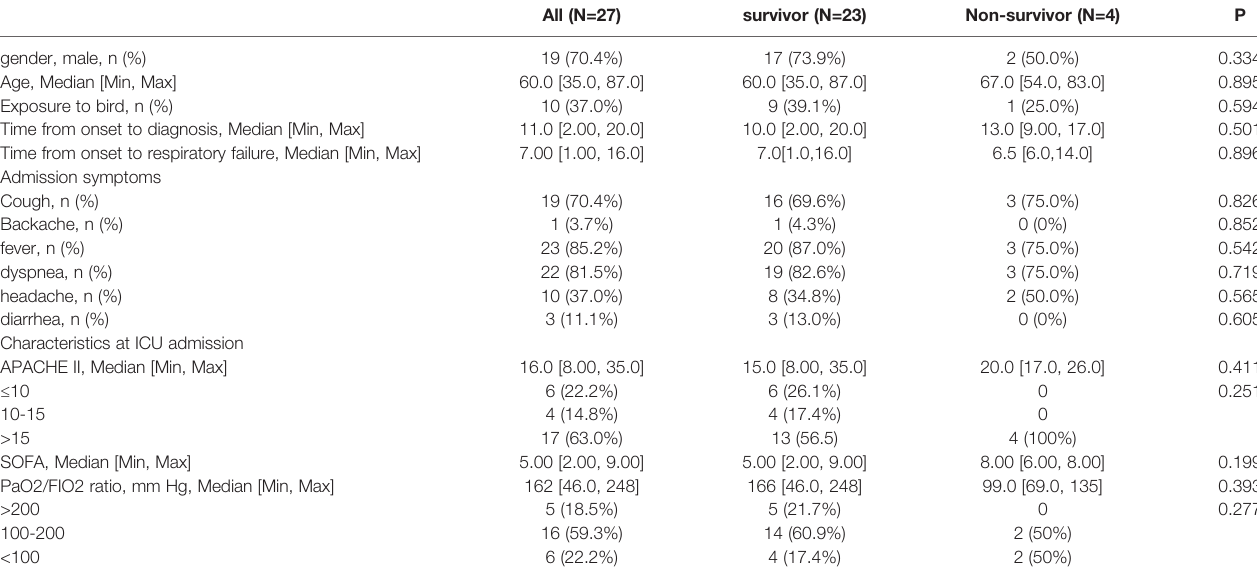
TABLE 1 | Basic characteristics of patients (n = 27) included in the